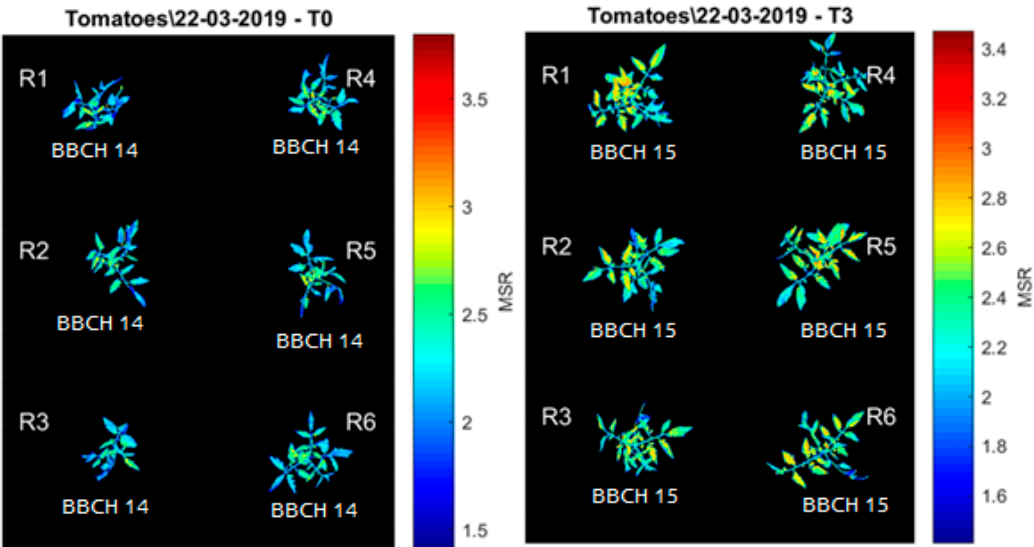
Figure 7. Example of vegetation indices obtained through the Parrot Sequoia camera and segmentation algorithm. Modified Simple Ratio (MSR) image and phenological state (BBCH scale) of the T0 treatment (left) and the T3 treatment (right).